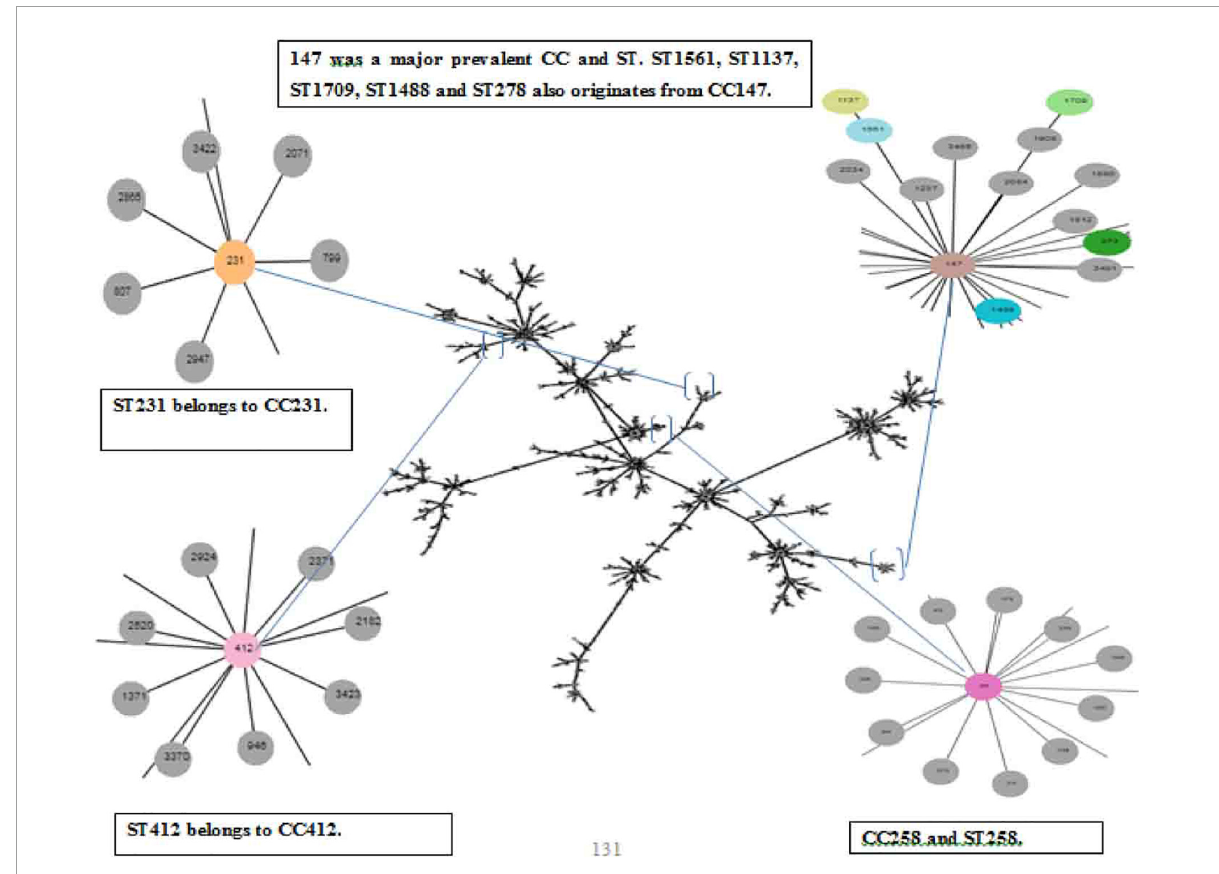
FIGURE1 eBURST analysis (Phyloviz) of Klebsiella pneumoniae representing the STs and CCs, Partial snapshots of branches magnified and highlighted each CC and ST found in the